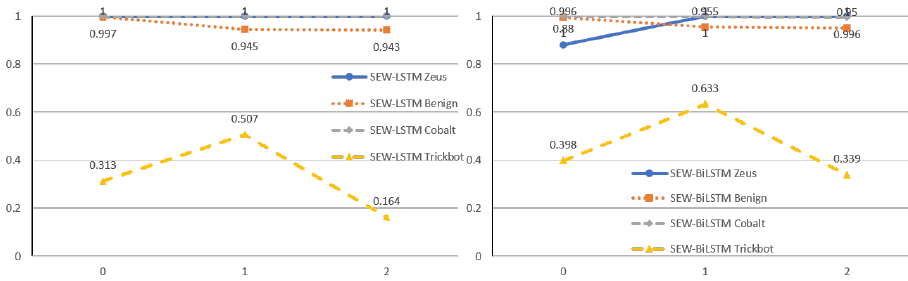
Figure 7. Multiclass target evaluation results using SEW-LSTM and SEW-BiLSTM. The x-axis is the payload from zero (with no binning), one, and two or more, while the y-axis is the F1